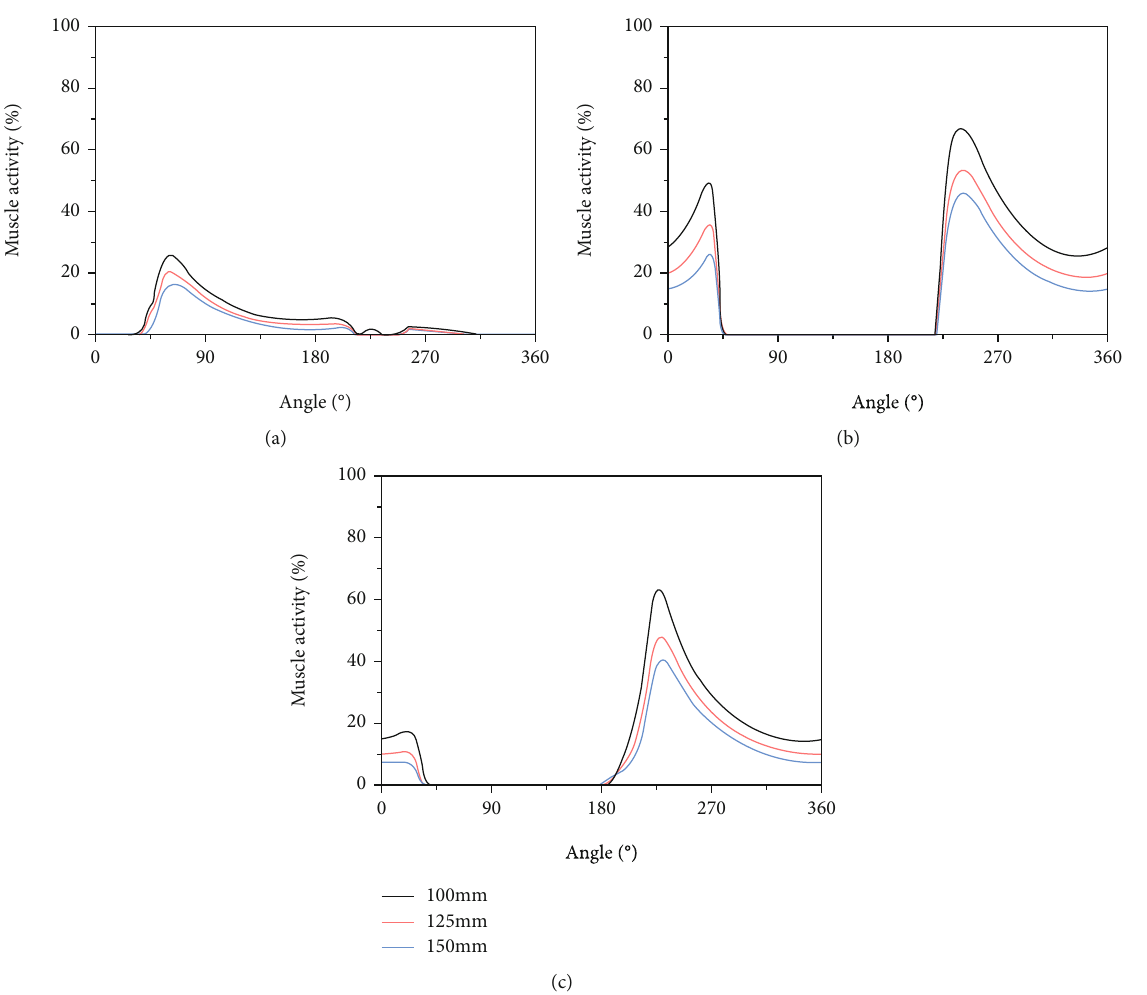
Figure 4: The activity of the TA, VL, and RF muscles during a cycle (0 ° -360 ° ) with di ff erent crank lengths (100mm, 125mm, and 150 mm). (a) TA, (b) VL, and (c)